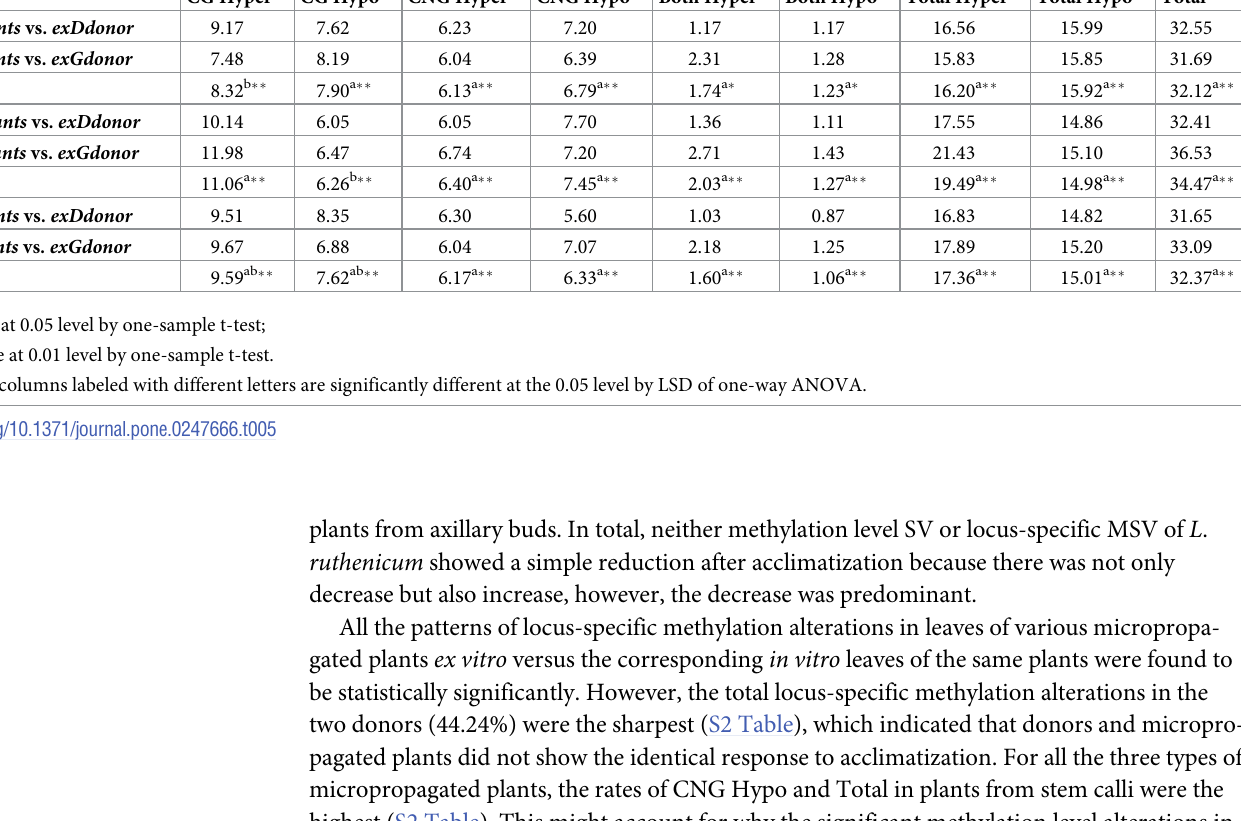
Table 5. Changes in cytosine methylation pattern in the ex vitro plants regenerated from leaf calli and stem calli, and ex vitro plantlets derived from axillary buds compared with the corresponding ex vitro donors of L . ruthenicum . Comparison within two groups